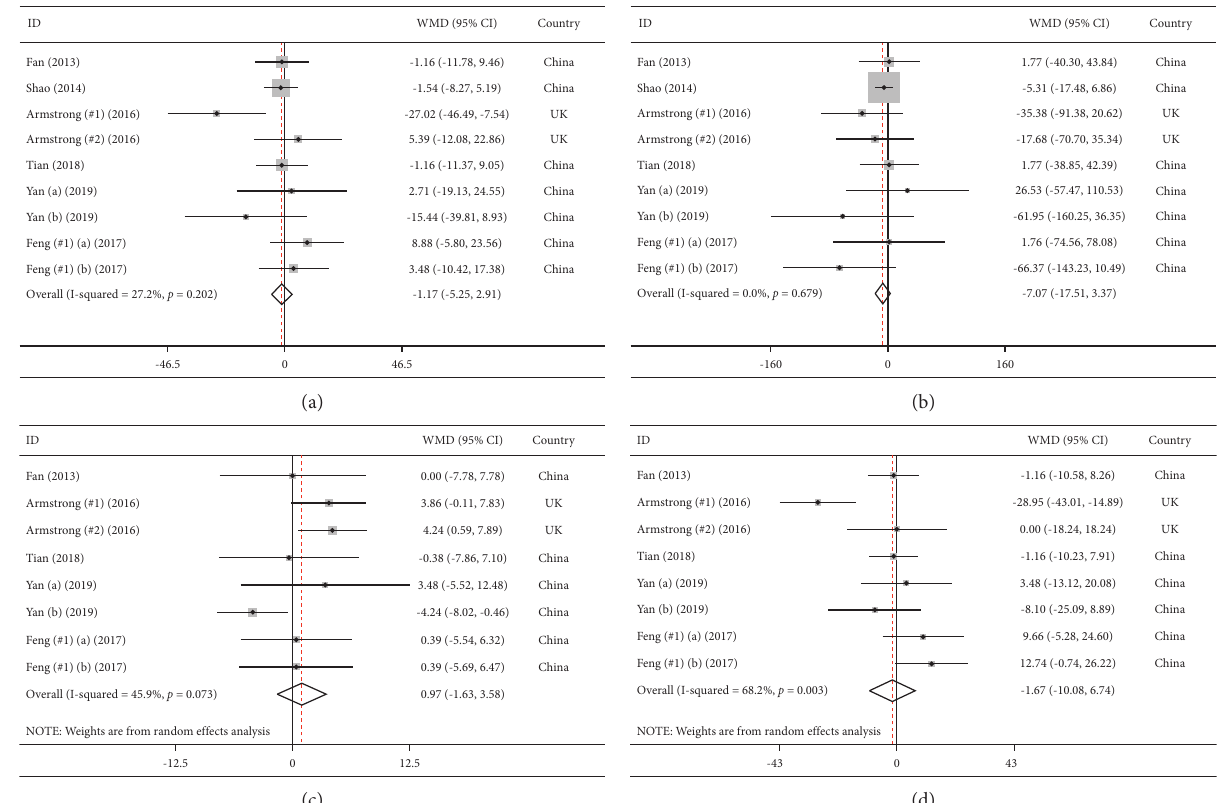
Figure 3: Meta-analysis of weighted mean differences estimates for lipid profiles including (a) total cholesterol, (b) triglycerides, (c) HDL- cholesterol, and (d) LDL-cholesterol in intervention and placebo groups (CI � 95%).